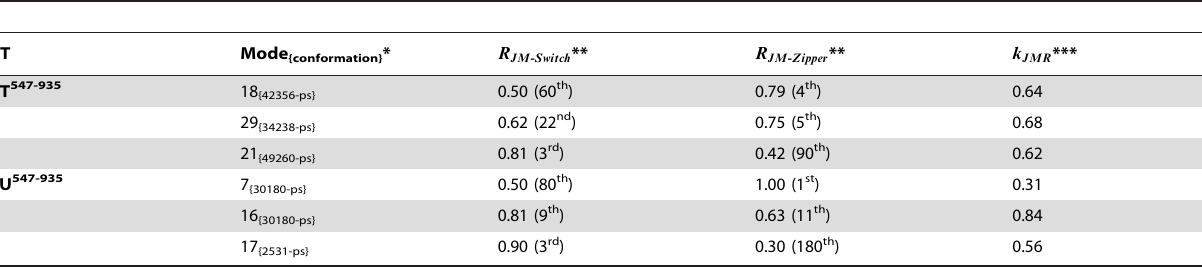
Table 2 . Characteristics of six normal modes representative of WT 547-935 and MU 547-935 inactive KIT motions.